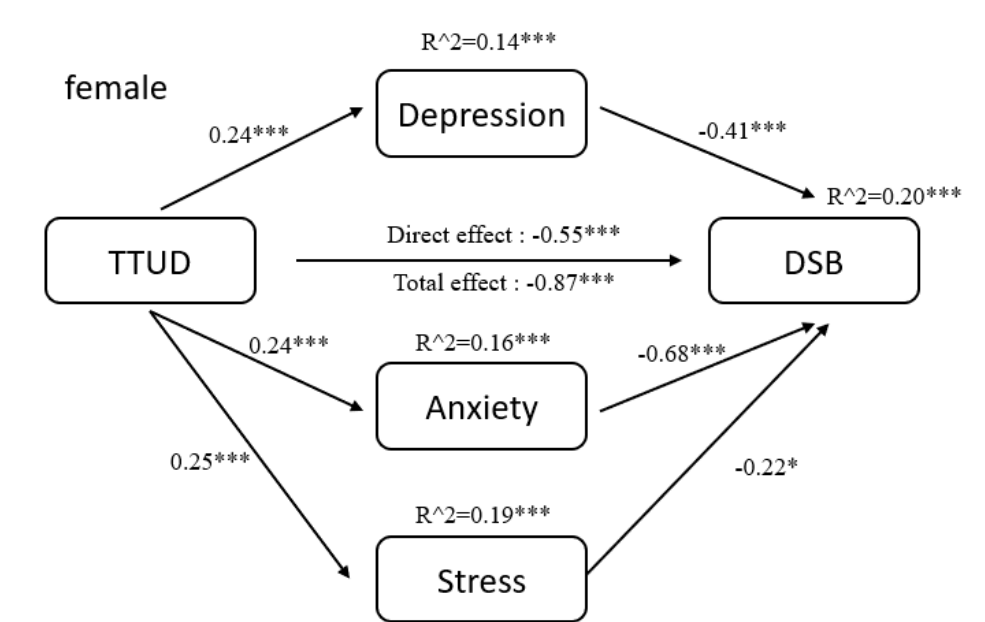
Figure 7. Structural model of backward digit span test for female participants. * p < 0.05, *** p < 0.001.